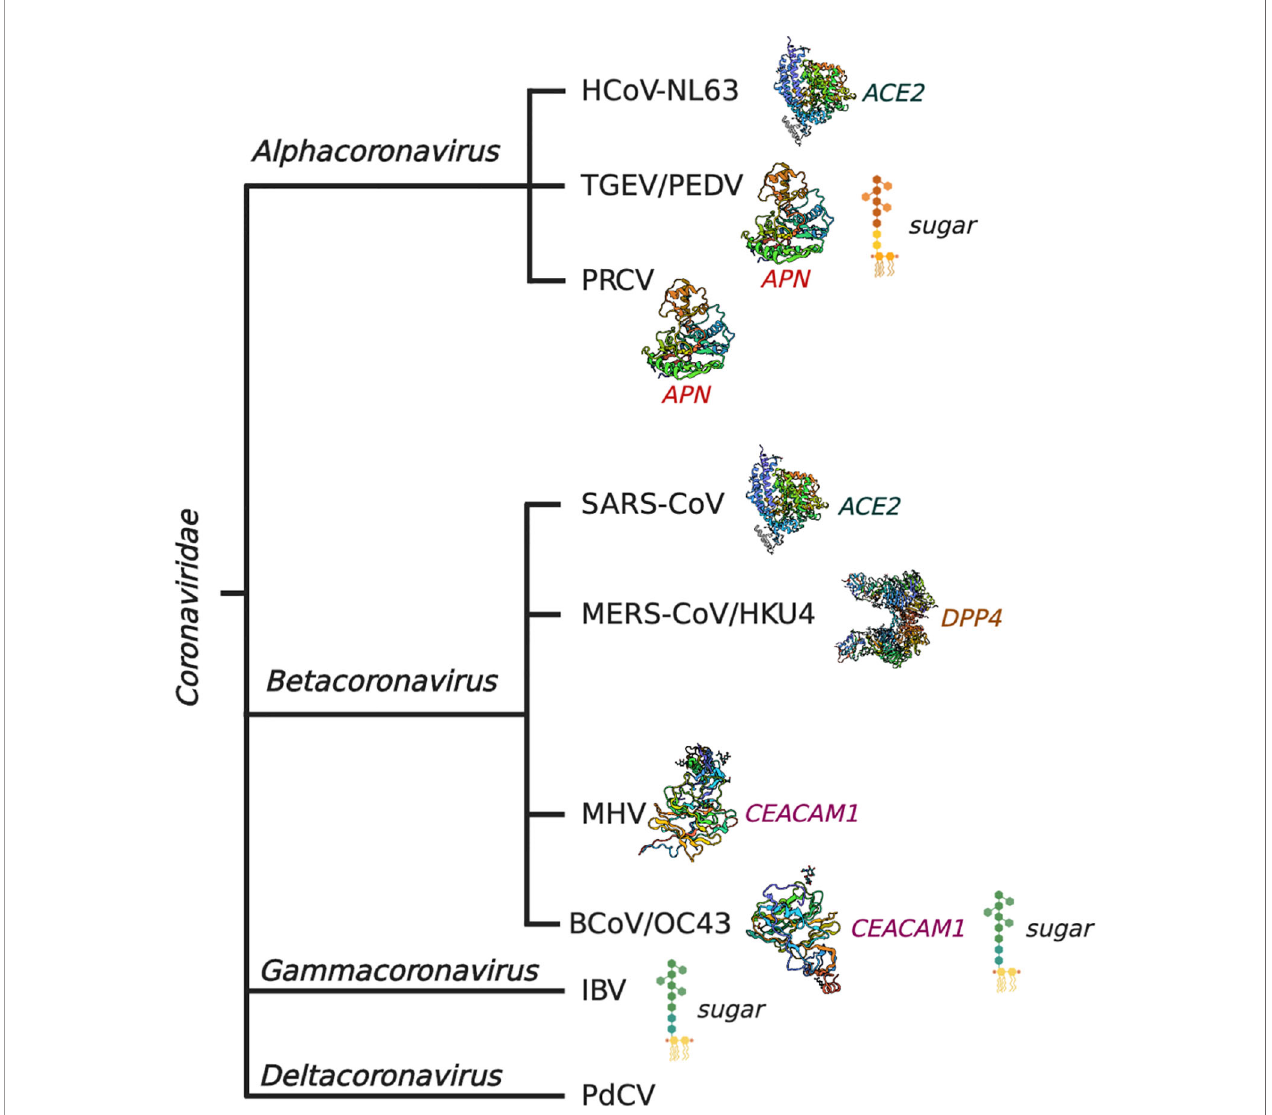
FIGURE 3 | Classi fi cation of coronaviruses and their respective mechanisms of host cell adhesion and